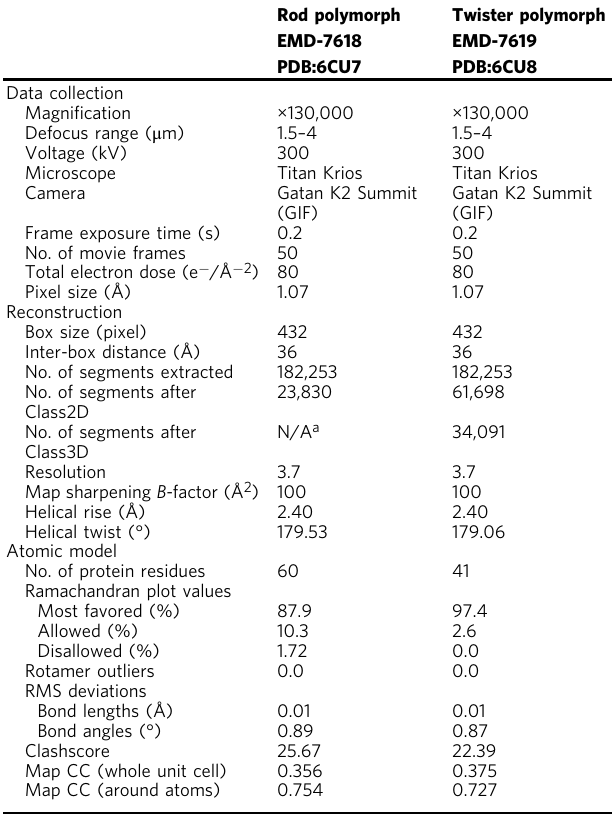
Table 1 Cryo-EM data collection, re fi nement, and validation